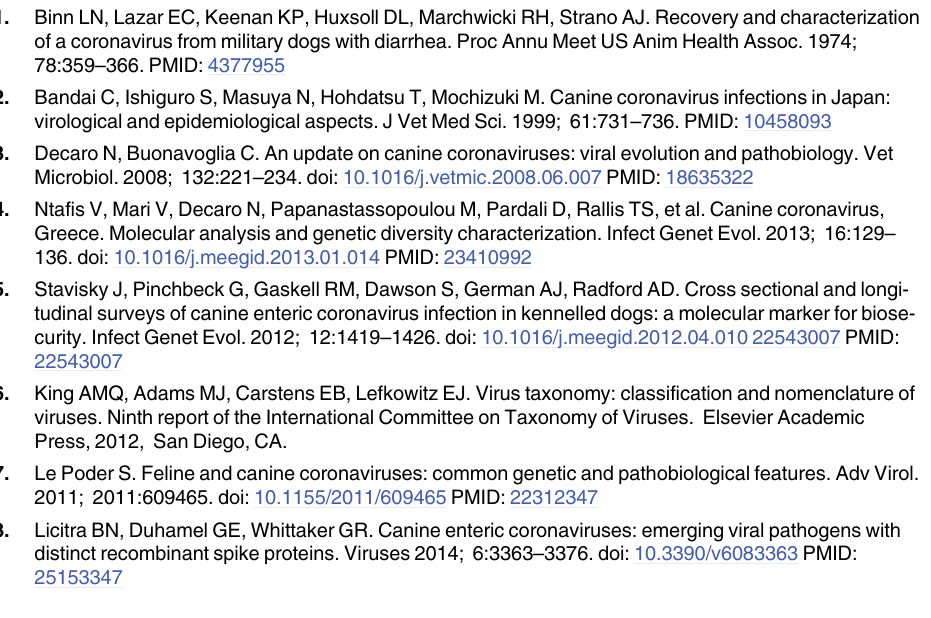
S1 Fig. Nucleotide sequences of the partial M gene of CCoV strains identified in our study. S2 Fig. Nucleotide sequences of the partial S gene of CCoV strains identified in our study. S1 Table. Characteristics of the CCoV positive dogs, genotyping of CCoV strains, and amino acid substitution of the partial M protein in northeast